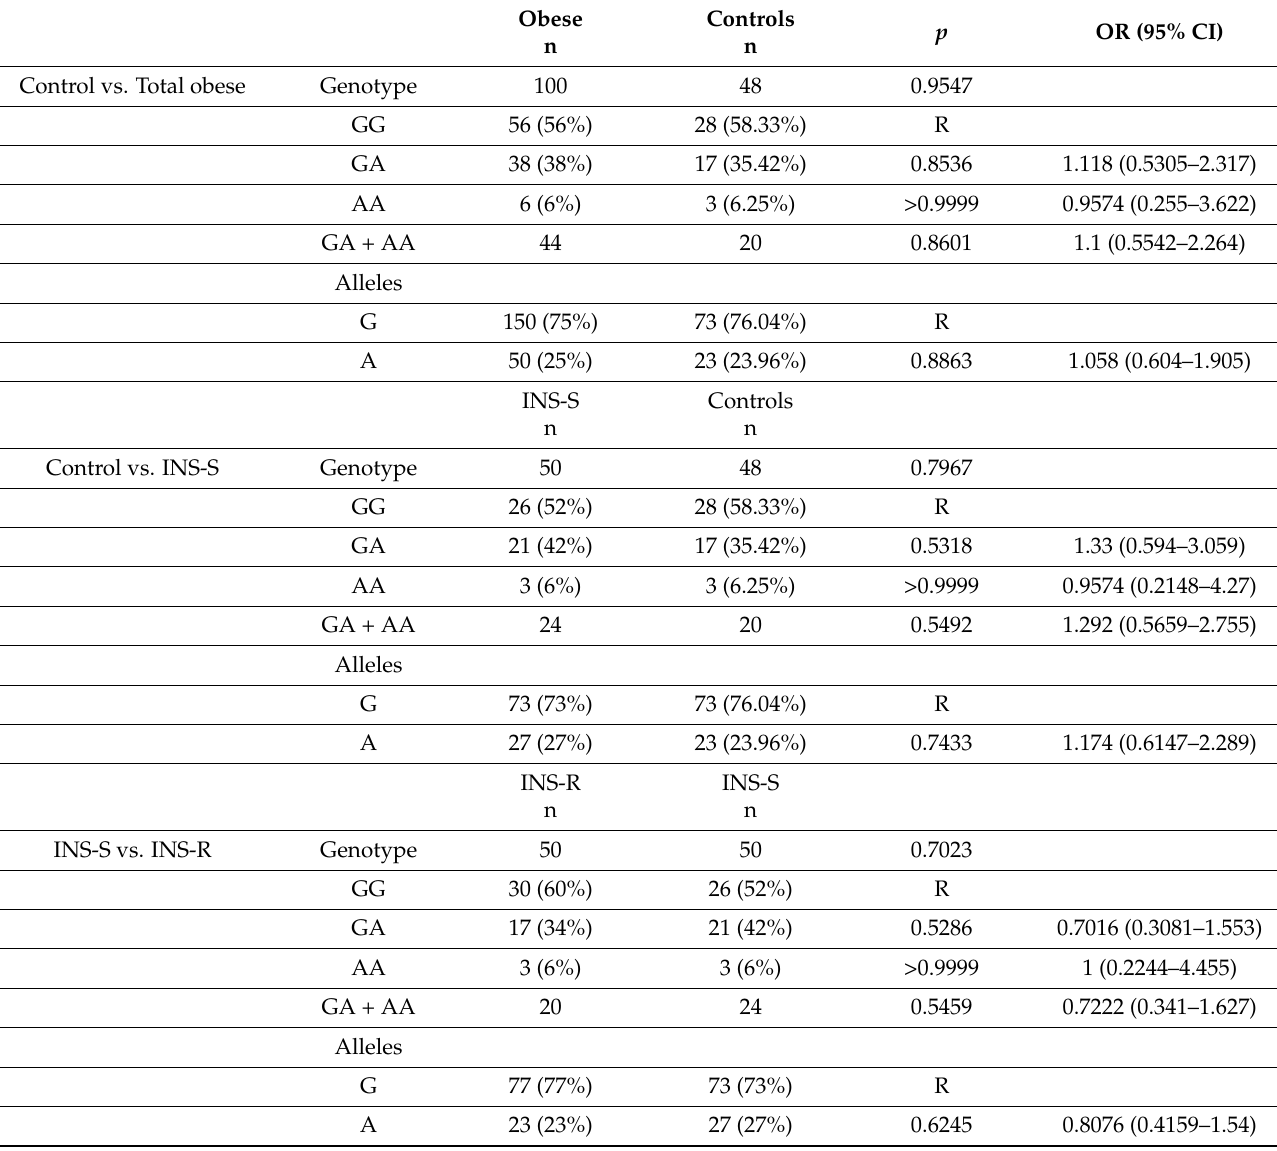
Table 4. Genotype distributions and allele frequencies of SNP rs217727 in H19 gene in control vs. obese, control vs. INS-S, and INS-S vs. INS-R groups. Obese Controls p OR (95% n n